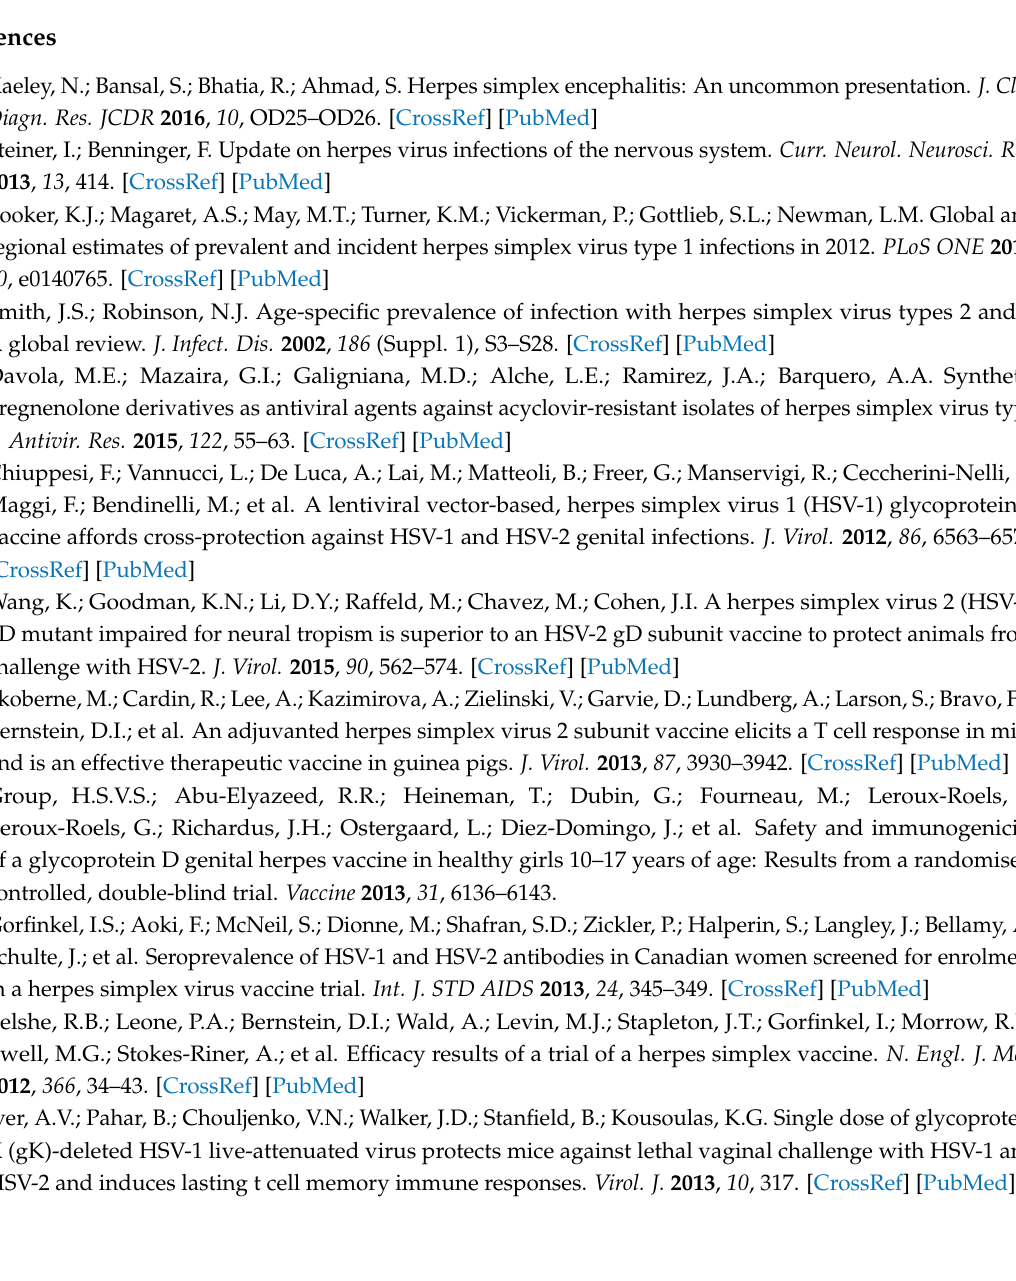
Figure S1: Pathological features M3 low-dose- and PBS-inoculated macaques challenged with wild-type 17 + strains; Table S1: Clinical observations of macaques inoculated with the M3 (high and low dose) and PBS groups; Table S2: Histopathological detection of various tissues in the high-dose group; and Table S3: Histopathological detection in tissues in the M3 low-dose and PBS control